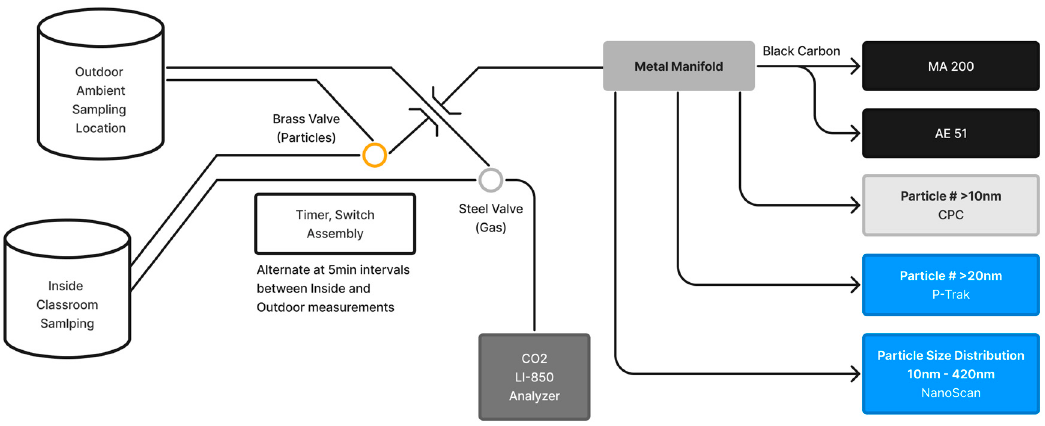
Figure 3. Pneumatic configuration of sampling instruments.